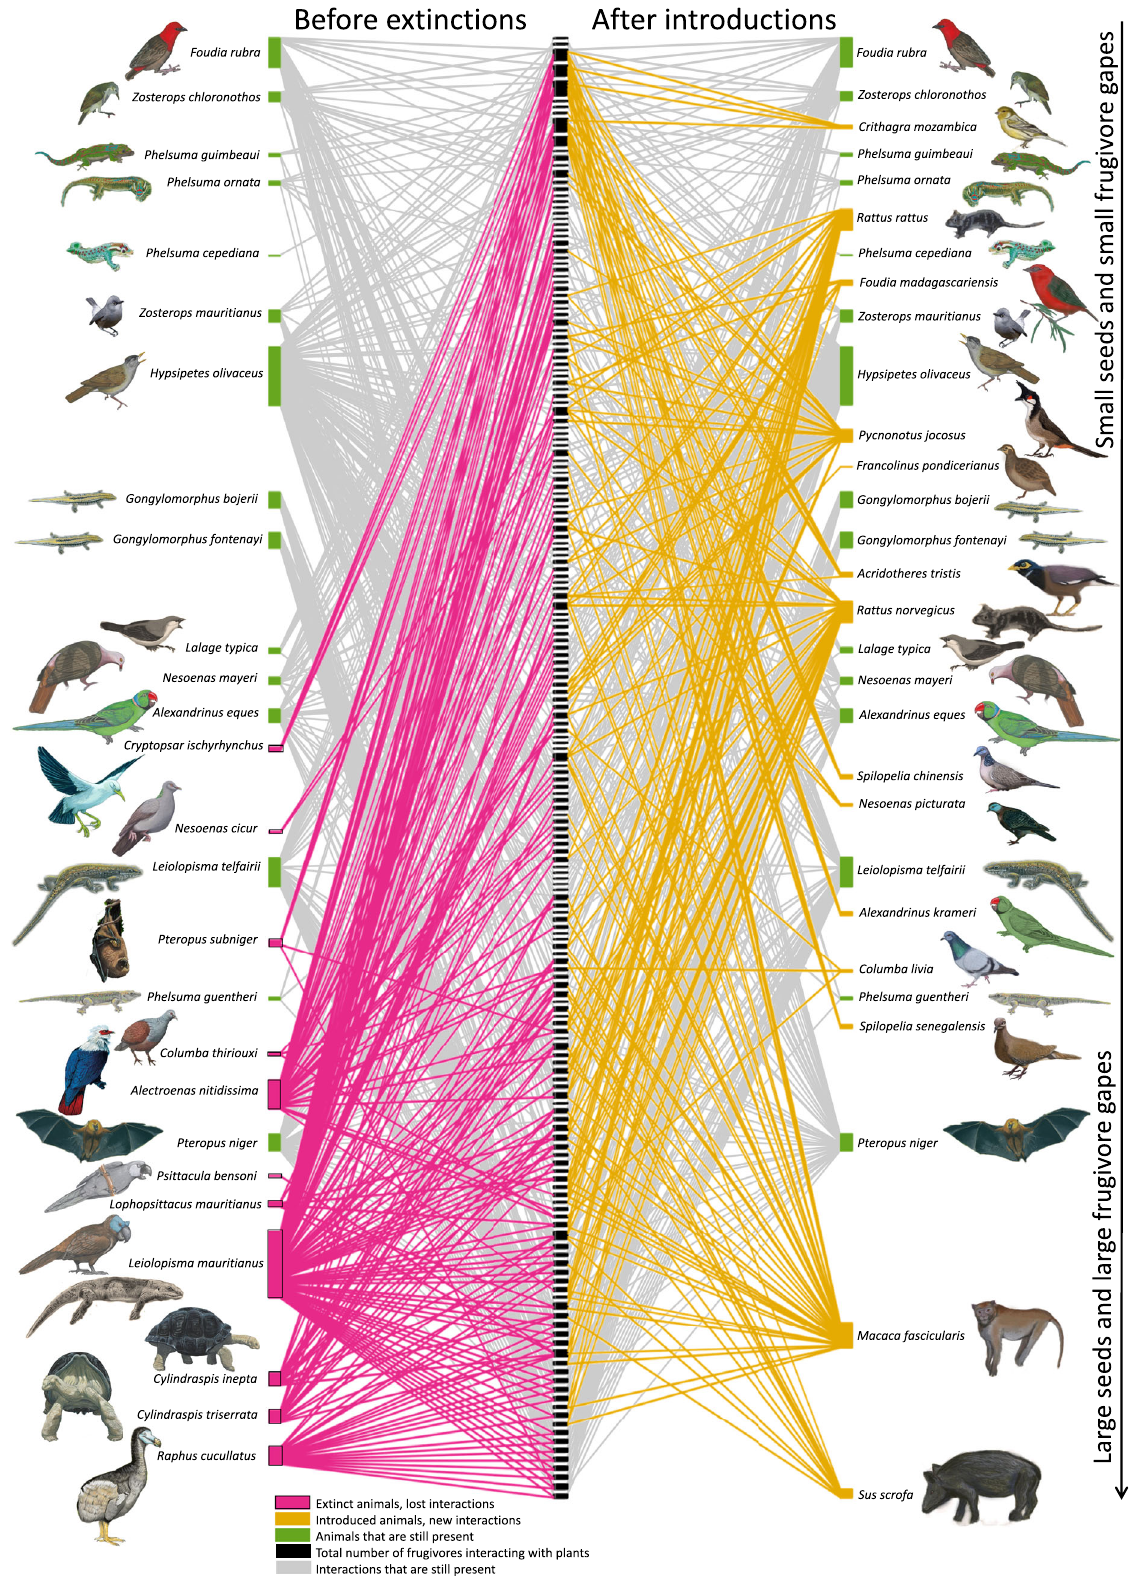
Fig. 3 | Loss and gain of interactions in Mauritian frugivory networks before extinctionsandafterintroductions. Interactionnetworkbetweenfrugivoresand native fl eshy-fruitedplantsonMauritius,beforeandafterfrugivoreextinctionsand